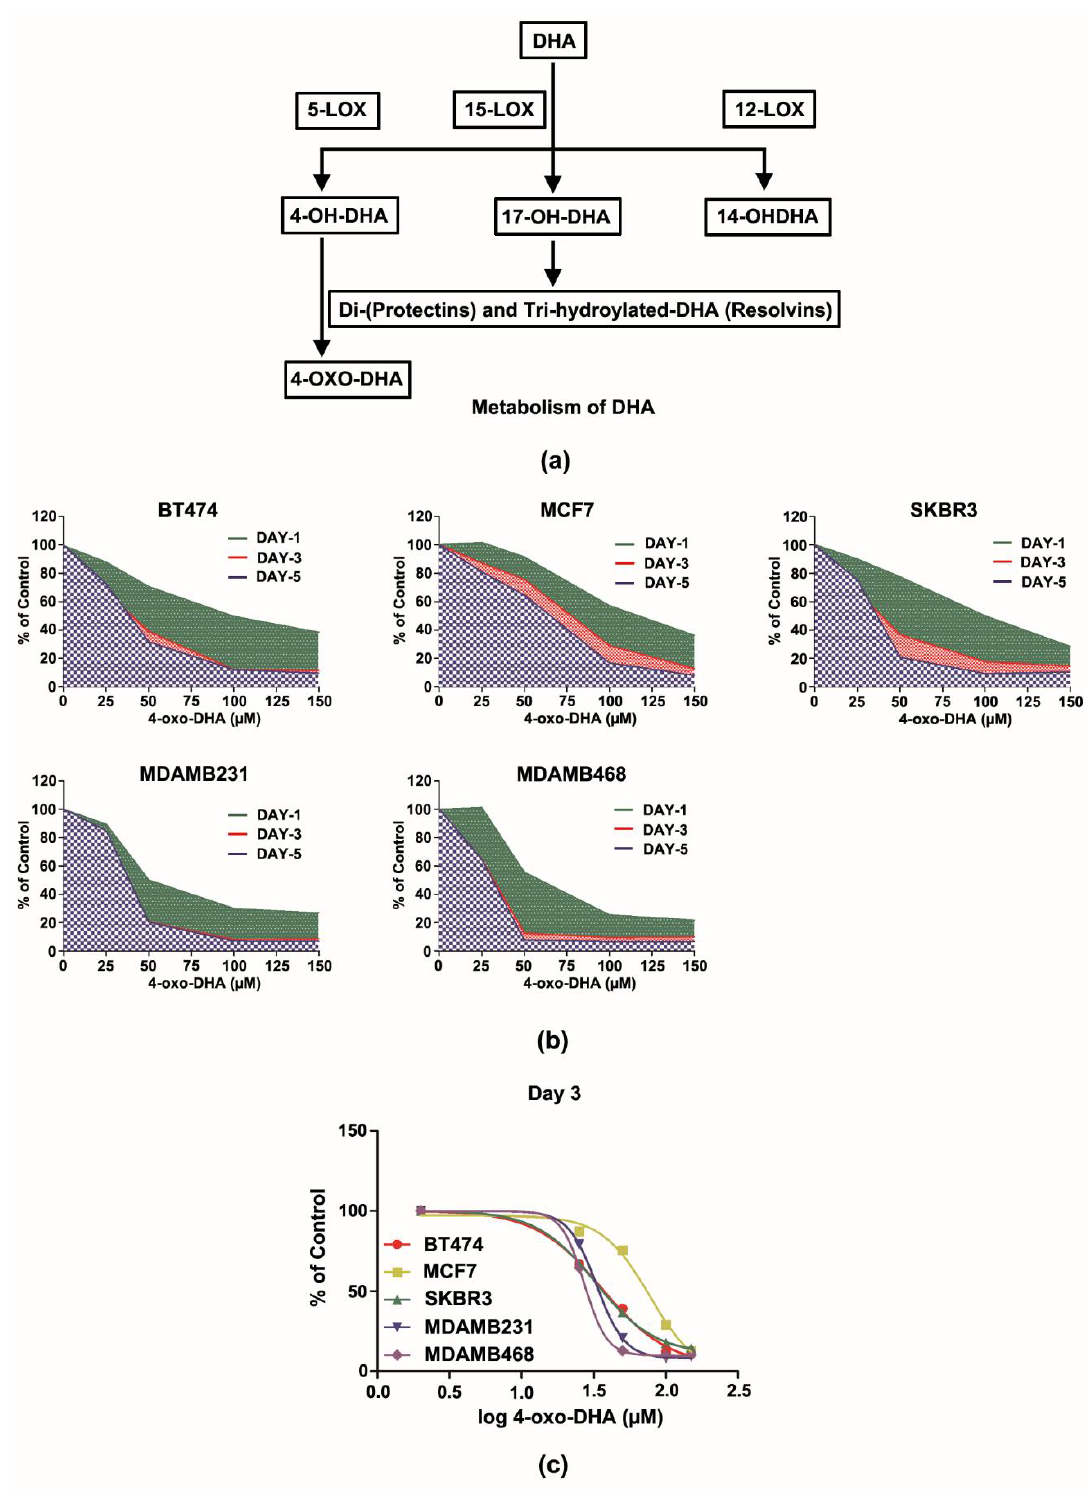
Figure 2. Metabolism of docosahexaenoic acid (DHA) and the dose- and time-dependent effects of 4-oxo-DHA on the growth of five subtype human breast cancer cells (BT474, MCF7, SKBR3, MDAMB231, and MDAMB468) graphed using an area under the curve (AUC) or the half-maximal inhibitory concentration (IC50) as a percent of untreated control. ( a ) Metabolism of DHA; ( b ) an area under the curve analysis; ( c ) the half-maximal inhibitory concentration for 3 days of treatment.